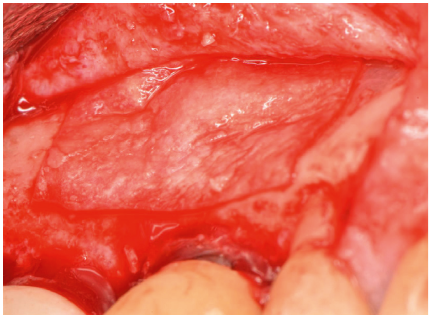
Figure 19: A collagen membrane placed over the grafted site.